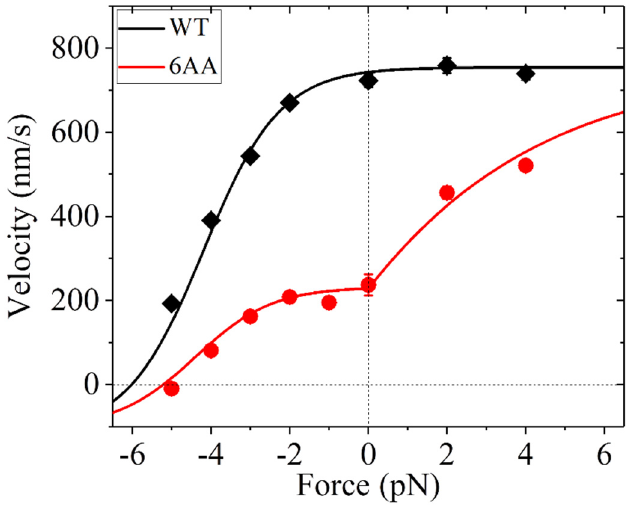
Figure 3. Dependence of velocity on backward and forward loads for human kinesin-1 motors. WT and 6AA represent the wild type and the mutant one with extension of each NL by inserting six additional residues AEQKLT, respectively. Lines are theoretical results. Symbols are experimental data taken from Andreasson et al. [37]. Table 2. Parameter values for human kinesin-1 motors.